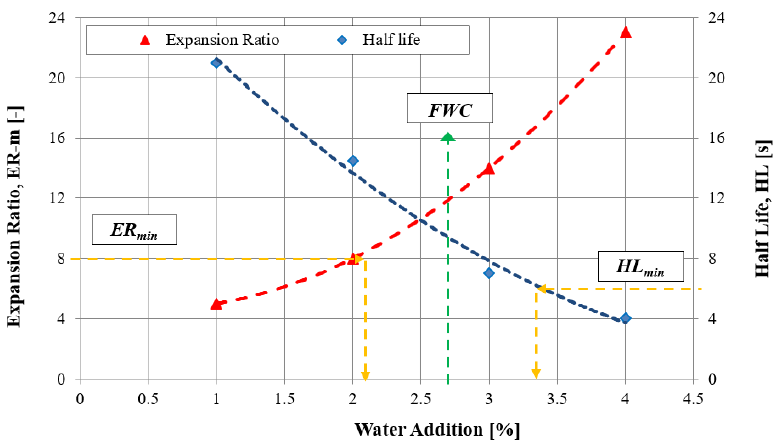
Figure 2. Characteristics of foamed bitumen for 50/70 paving grade